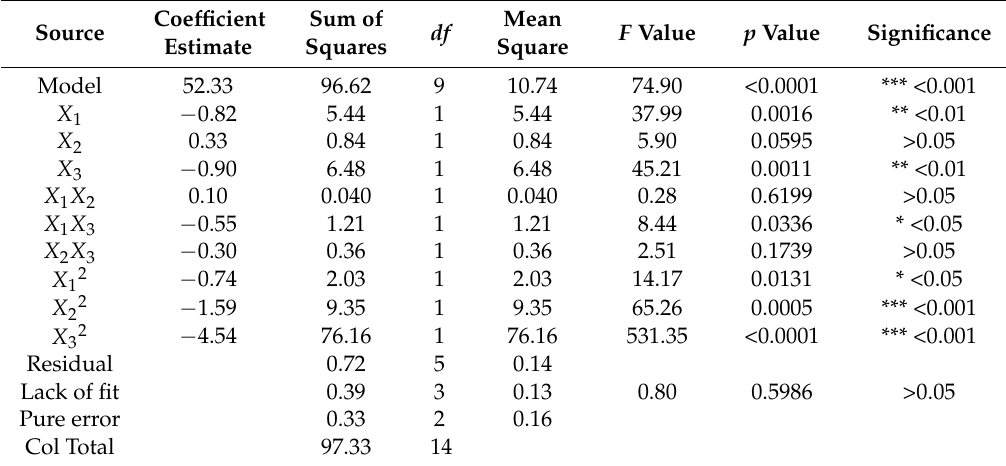
Table 2. Analysis of variables for regression model of response in extraction